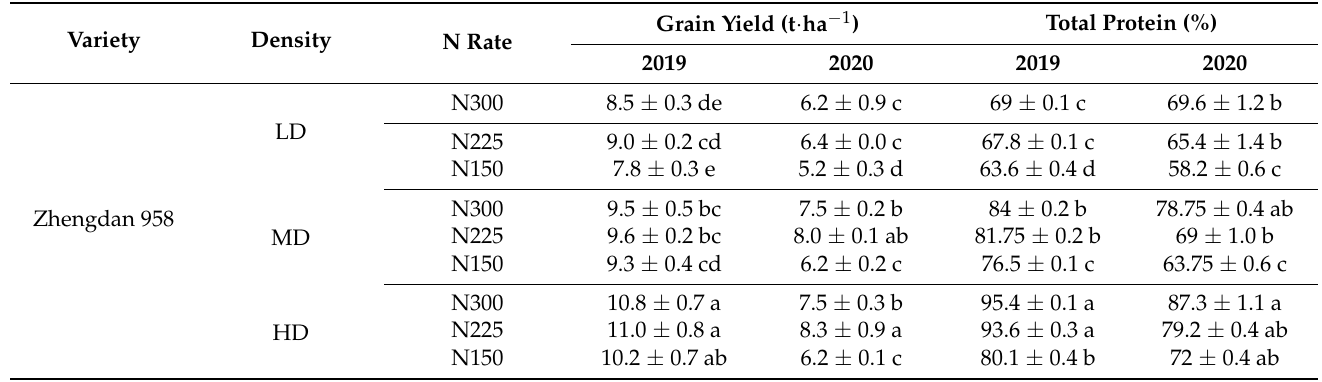
Table 6. Effects of densities and decreasing nitrogen rates on yield and protein content of summer maize in 2019 and